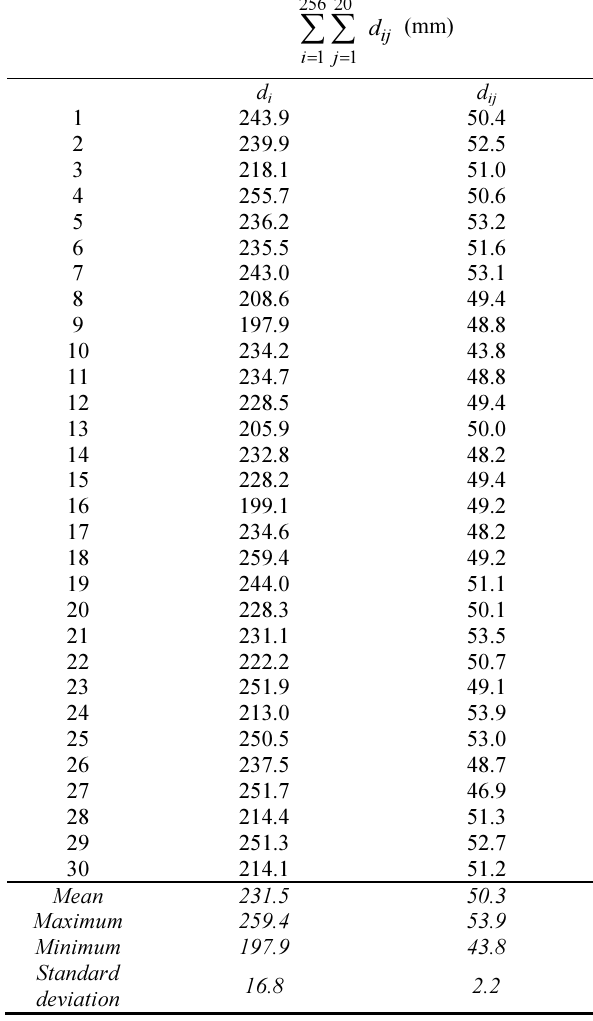
Table 2. Total deterioration of the standard deviation of the longitudinal level without maintenance